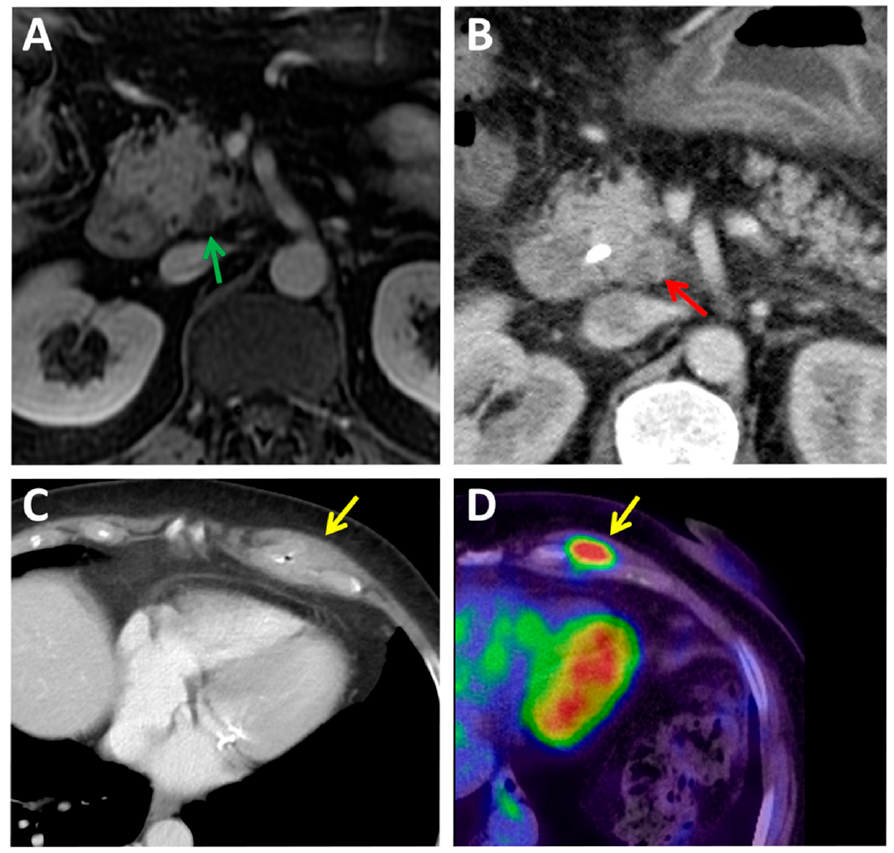
Figure 1. Cases of radiologically infra-staged and false-positive diagnosis of metastatic tumor recurrence by current imaging methods. ( A , B ) A radiologically infra-staged T2 N0 pancreatic ductal adenocarcinoma (PDAC) was found to be a locally advanced pT4 pN1 PDAC in the pathology report. ( A ) magnetic resonance imaging (MRI) showing a small cystic area in the pancreas’ uncinate process (green arrow), a bile duct stricture, no direct signs of malignancy. ( B ) A computed tomography (CT) performed after bile stent placement showed a small hypodensity (red arrow) next to the superior mesenteric artery. ( C , D ) A case of a false-positive diagnosis of metastatic tumor recurrence. ( C ) Some months after surgical excision of a PDAC stage pT2 pN0 M0 R0, an asymptomatic solid mass in the left costal wall (yellow arrow) was shown by a CT scan. ( D ) An 10.43 SUVmax in 2-[18F]fluoro-2-deoxy-D-glucose ([ 18 F]FDG) positron emission tomography (PET)-CT was suspicious of a PDAC metastatic relapse. A tumor core biopsy found inflammatory and fibrotic tissue but no sign of malignant cells. CT also allows the detection of distant metastases, liver, lung, or peritoneal infiltration. In the latter case, the existence of ascites, irregular peritoneal thickening, nodular thickening of the intestinal wall, or omental infiltration are suspicious signs [12]. In the diagnosis and staging of pancreatic cancer, PET/CT (Positron Emission Tomog- raphy/Computed Tomography) has a limited value. To date, few PET agents have been developed, with 2-[18F]fluoro-2-deoxy-D-glucose ([ 18 F]FDG) being the most widely used